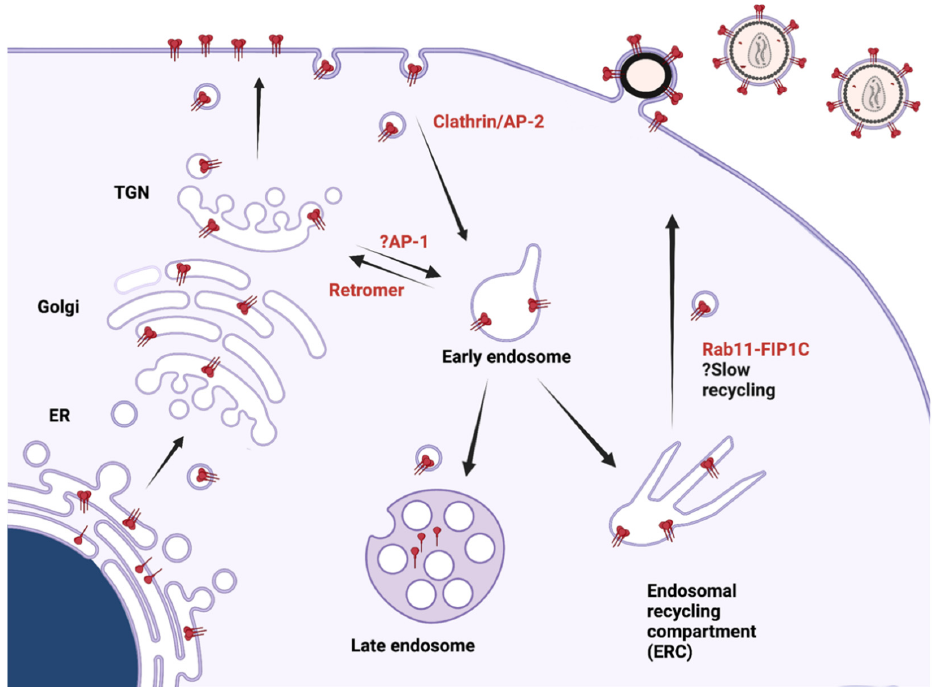
Figure 5. Host pathways implicated in Env trafficking and particle incorporation. Env is synthesized on ER-associated ribosomes, forming trimers in this organelle. As gp160 timers progress through the Golgi, they are glycosylated, and furin-mediated cleavage occurs in the TGN. The cleaved trimers reach the PM, followed rapidly by endocytosis into early endosomes. From here, multiple pathways are possible, including degradation in the late endosome/lysosome, retrograde transport to the TGN, and transport to the ERC. Evidence favors a role for outward recycling from the ERC in mediating Env incorporation into particles in a CT ‐ dependent manner. Shown are roles for clathrin/AP ‐ 2, retromer, a potential role for AP ‐ 1, and outward recycling mediated by Rab11 ‐ FIP1C. Figure compiled using BioRender.com (2022).